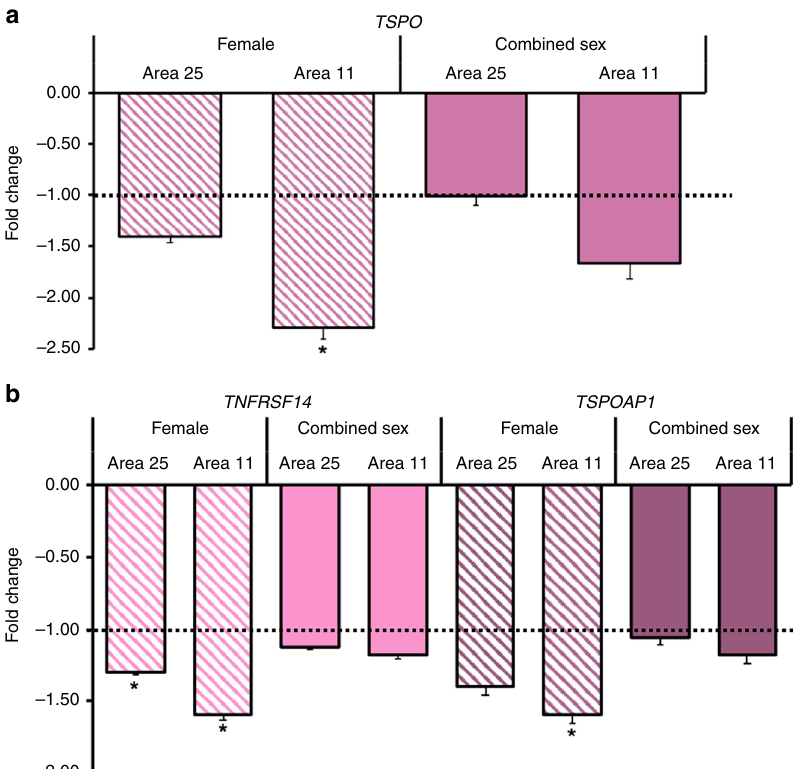
Fig. 4 Expression of TSPO , TNFRSF14 , and TSPOAP1 genes was lower in areas comprising the prefrontal cortex in a postmortem brain sample. a In females with PTSD ( n = 11) relative to female controls ( n = 11), TSPO expression was signi fi cantly lower in BA11 ( − 2.30-fold lower (±0.10), p = 0.01), but not in BA25. Prefrontal cortex TSPO expression was not signi fi cantly lower in PTSD ( n = 22) relative to controls ( n = 22) combined across sex. b Relative expression of TNFRSF14 was signi fi cantly lower in BA11 ( − 1.60-fold (±0.03), p = 0.01) and in BA25 ( − 1.30-fold (±0.02), p = 0.04) in the female PTSD subgroup ( n = 11 per subgroup). Relative expression of TSPOAP1 was signi fi cantly lower in BA11 ( − 1.60-fold (±0.06), p = 0.04) in the female PTSD subgroup ( n = 11 per subgroup). Apparent lower relative expression did not reach statistical signi fi cance for TSPO and TSPOAP1 in BA25 in the female subgroup, and for TSPO , TNFRSF14 , and TSPOAP1 in BA11 in PTSD vs. controls combined across sex. Mann-Whitney U tests were used to assess differences in fold change. Displayed values are shown as fold change ( − log 2 (dd C T )) -1 , representing the fold change in transcript expression, or the ratio of the average d C T in the PTSD relative to average d C T in the control group. Error bars indicate the log-corrected SD of d C T calculated from the comparison PTSD sample. * p < 0.05, after Bonferroni correction for multiple comparisons for two exploratory